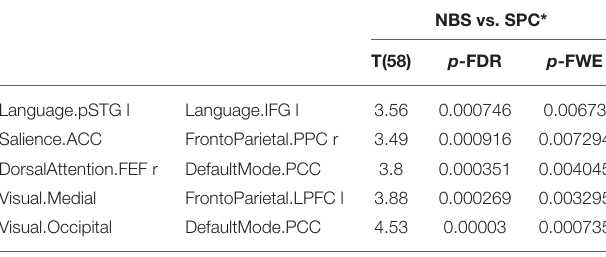
TABLE 5 | The significant increase in functional connectivity in older females obtained only in SPC analysis, not found in NBS method.